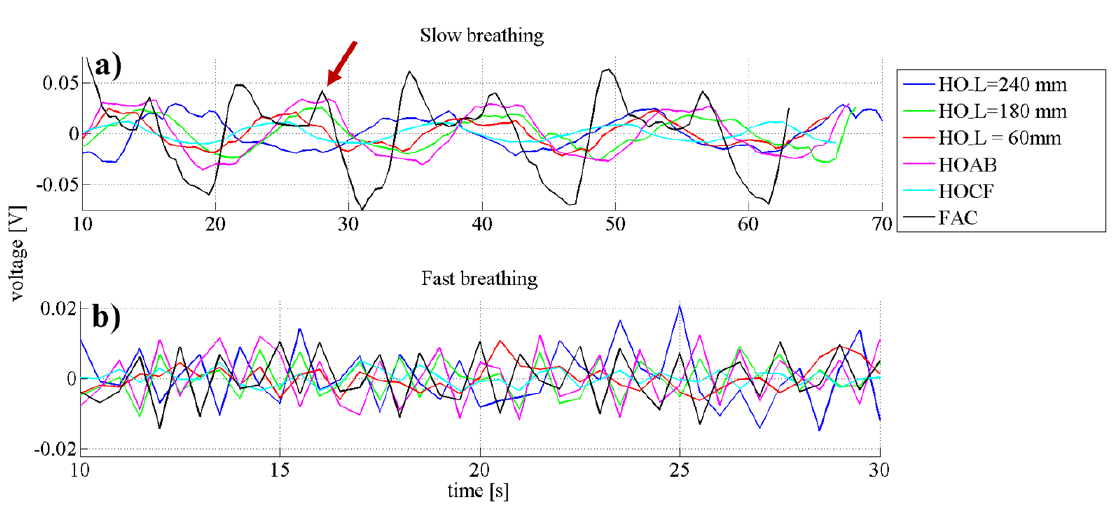
Figure 6. Graphs representing the data required to evaluate which sensor form is the best suited for respiratory rate measurements. On top slow breathing and on the bottom fast breathing.